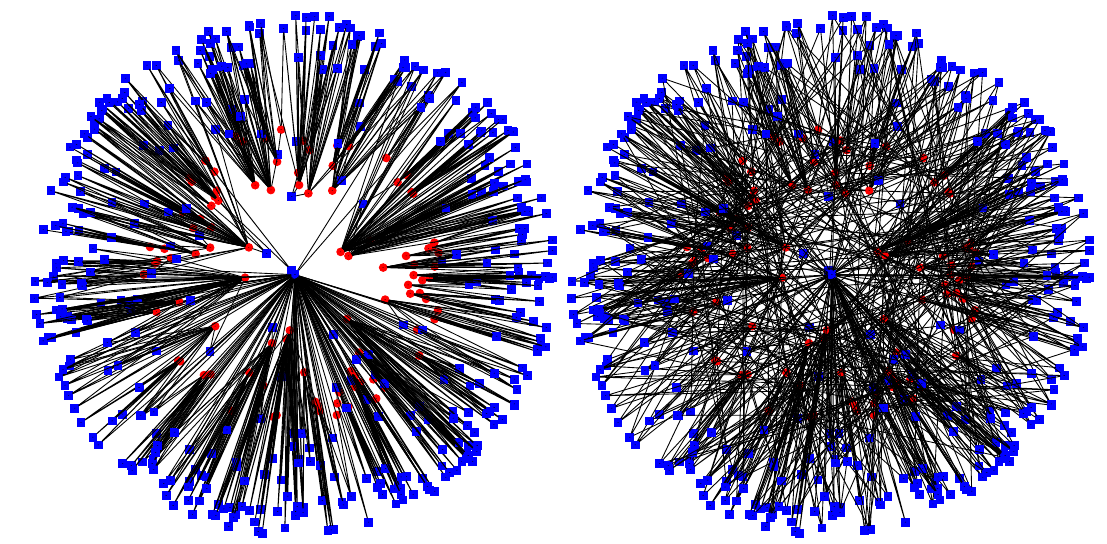
Fig. 1 Graphical representation of PS formulas with low T = 0.1 tively. The ( x , y ) coordinates of each node represent their radius and T = 10 n = 100 m = 425 their angle, respectively (left) and high (right), generated with , , and 𝛽 = 0.8 . Blue and red nodes represent variables and clauses, respec-